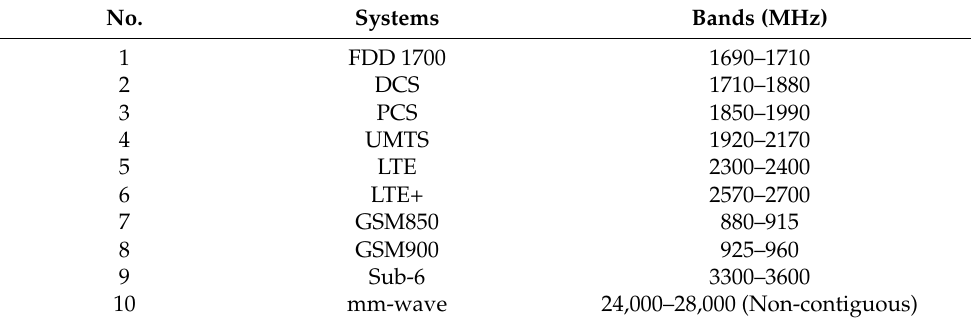
Table 2. Widely adapted frequency bands for mobile communication